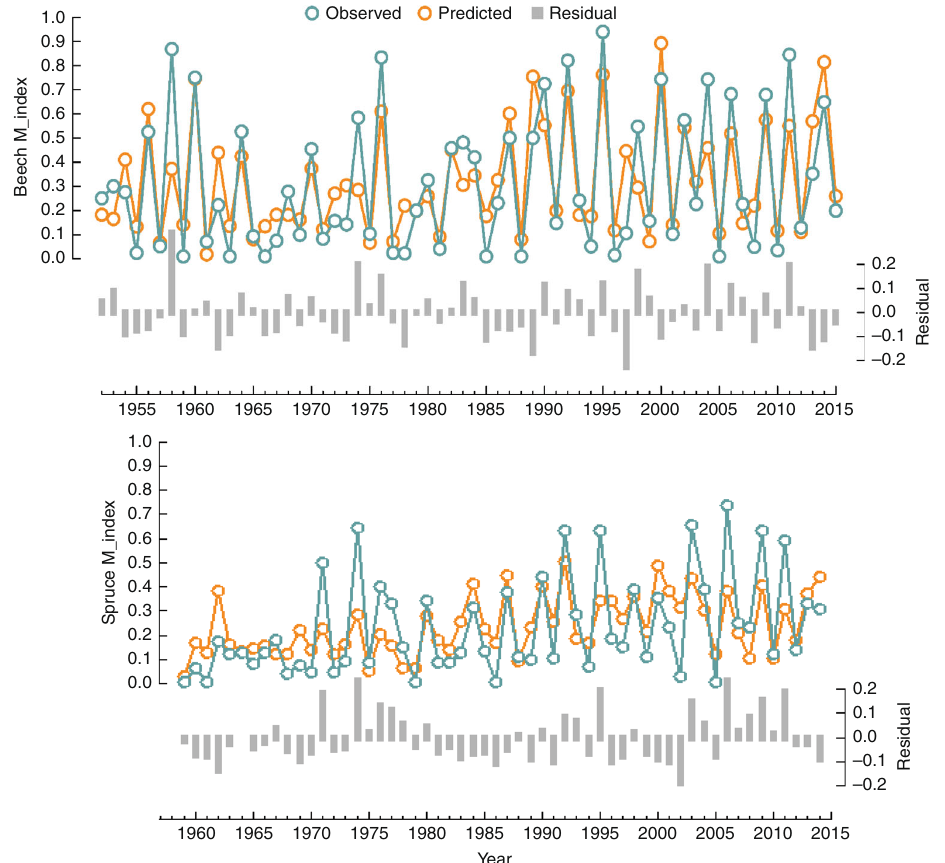
Fig. 1 Observed and predicted values of the masting indexes. Observed (blue line) and predicted (orange line) yearly values of M_index (scaled from 0 to 1) calculated for Central and Northern Europe for beech ( fi rst row, 1950 – 2015) and spruce (second row, 1959 – 2014). Predicted values estimated according to the fi nal model in Table 2. Gray bars are the model